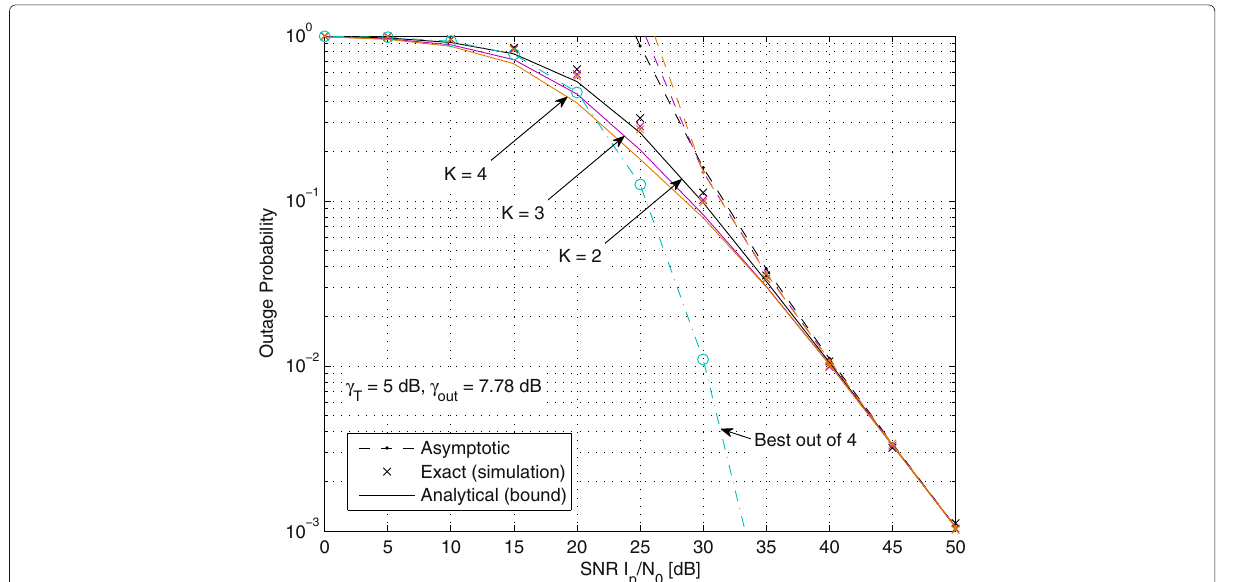
Fig. 3 Outage probability vs SNR of cognitive AF relay network with MUSwiD user selection scheme for different values of K and (cid:3) s,p = 30, and = 0.8, (cid:3) = 0.1, (cid:3) = 0.7 for k = 1, ... (cid:3) s,r r,p r, k